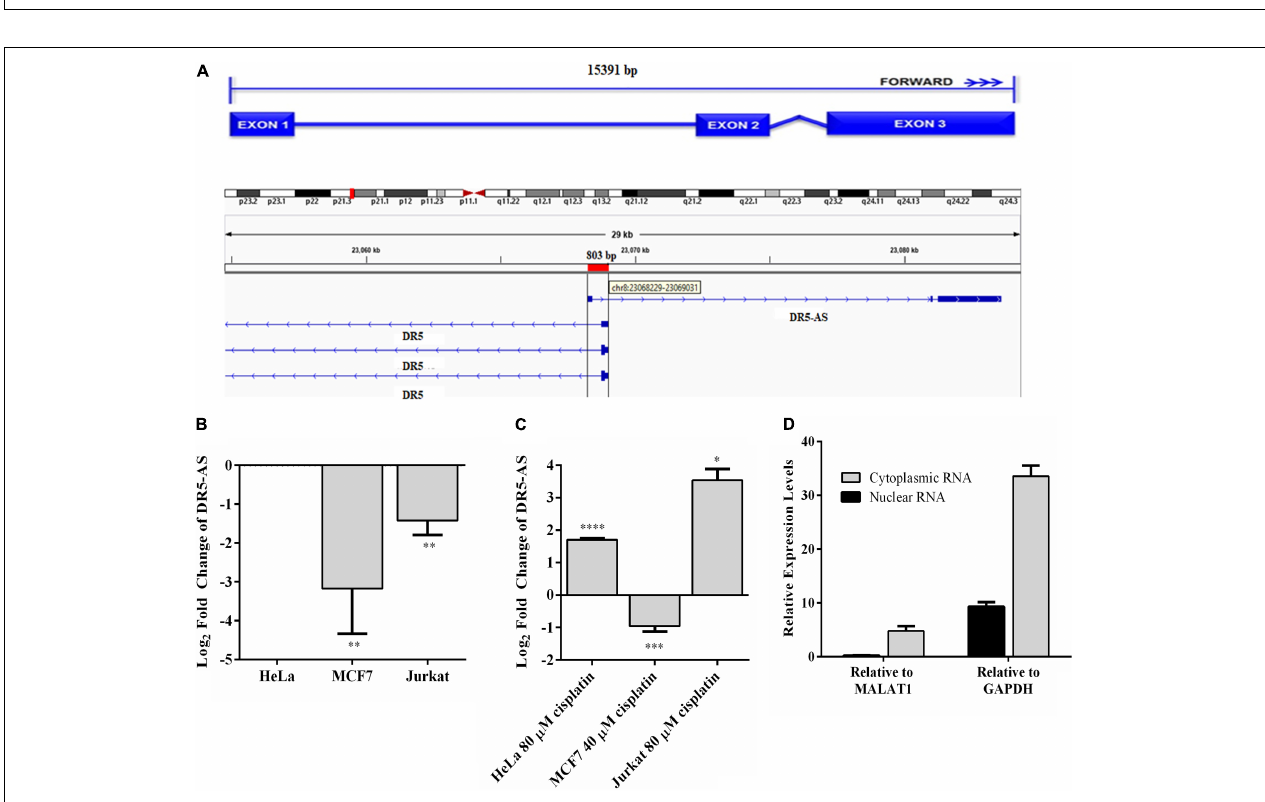
FIGURE 3 | Genomic location of DR5-AS and its expression in cisplatin-treated HeLa cells. (A) Schematic representation of DR5-AS (ENSG00000246130) and interference with DR5 transcript variant combined with the Ensembl structure. (B–D) qPCR analysis of DR5-AS expression in untreated cells ( B , normalized to DR5-AS expression in HeLa cells), cisplatin-treated cells ( C , normalized to DR5-AS expression in DMSO-treated cells), and fractionated cells (D) . Cisplatin treatment and qPCR analyses were performed as explained in Figure 2B . Subcellular localization of DR5-AS was determined by qPCR analyses of nuclear and cytoplasmic RNAs isolated from cisplatin-treated HeLa cells. MALAT1 and GAPDH were used as markers for nuclear and cytoplasmic fractions, respectively. Ct values for the cytoplasmic and nuclear GAPDH were 9.7 and 13.9, respectively. Ct values for DR5-AS for the cytoplasmic and nuclear fractions were 25.2 and 20.8, respectively. p > 0.05, ∗ p ≤ 0.05, ∗∗ p ≤ 0.01, ∗∗∗ p ≤ 0.001, and ∗∗∗∗ p ≤ 0.0001.